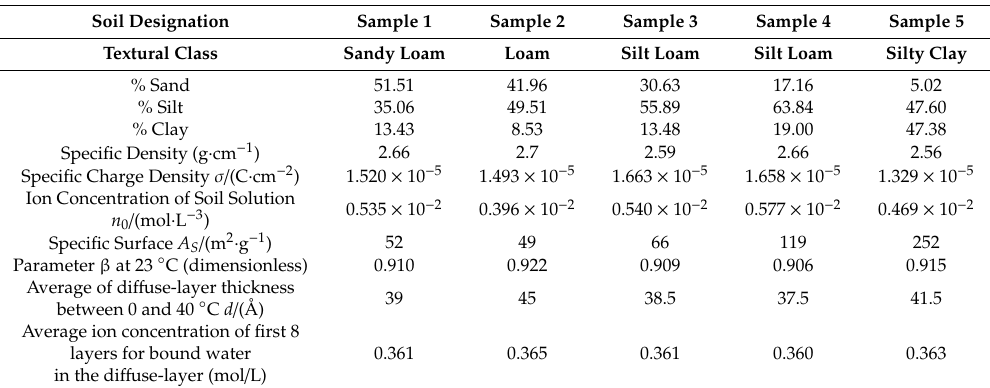
Table 1. Soil physical parameters for calculating the electric double-layer